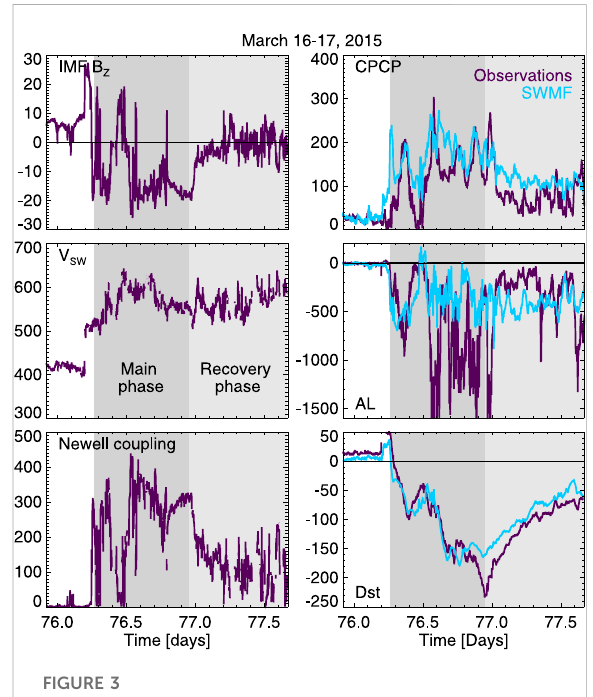
FIGURE 3 (Left panel) Solar wind driver parameters: (Top) IMF B Z in nT; (Middle) solar wind speed in km/s; and (Bottom) Newell coupling function(arbitraryunits,seetext).(Rightpanel)Geomagneticindex response: (Top) Cross-polar cap potential in kV; (Middle) Auroral electrojet AL index in nT; and (Bottom) Storm Dst index in nT. The observed valueas are shown in dark blue, the SWMF simulation values in light blue. Storm main phase (from start of Dst decrease to peak Dst) and recovery phase (from peak Dst to storm end) are shown with darker and lighter gray shading,